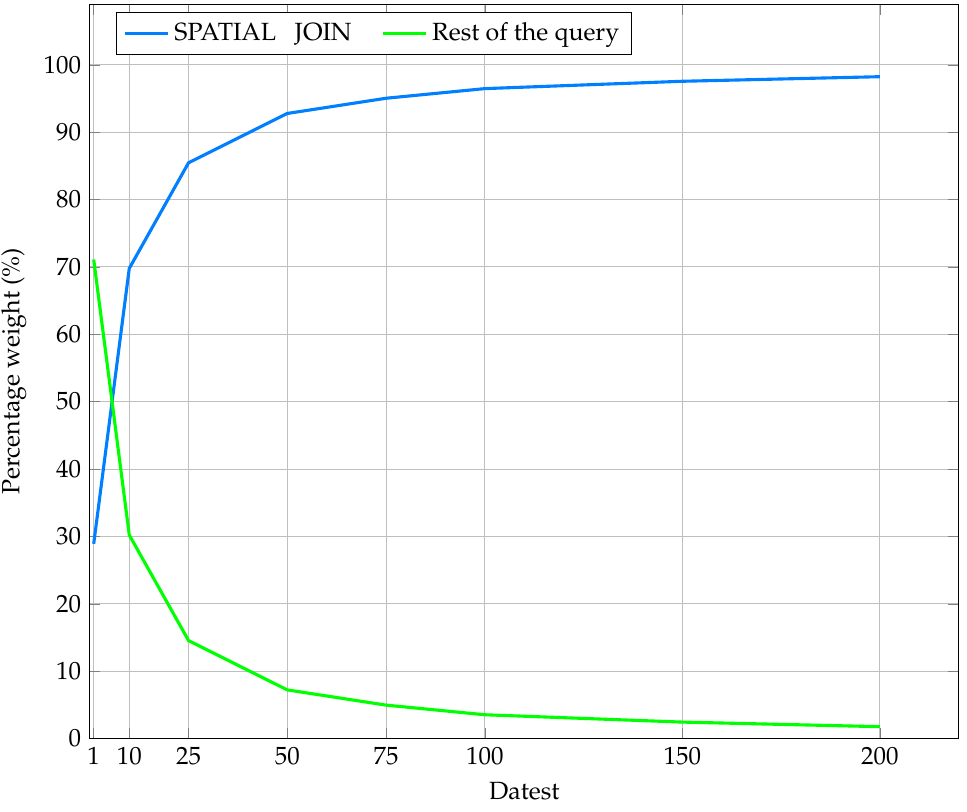
Figure 8. Percentage weight of SPATIAL JOIN on the overall